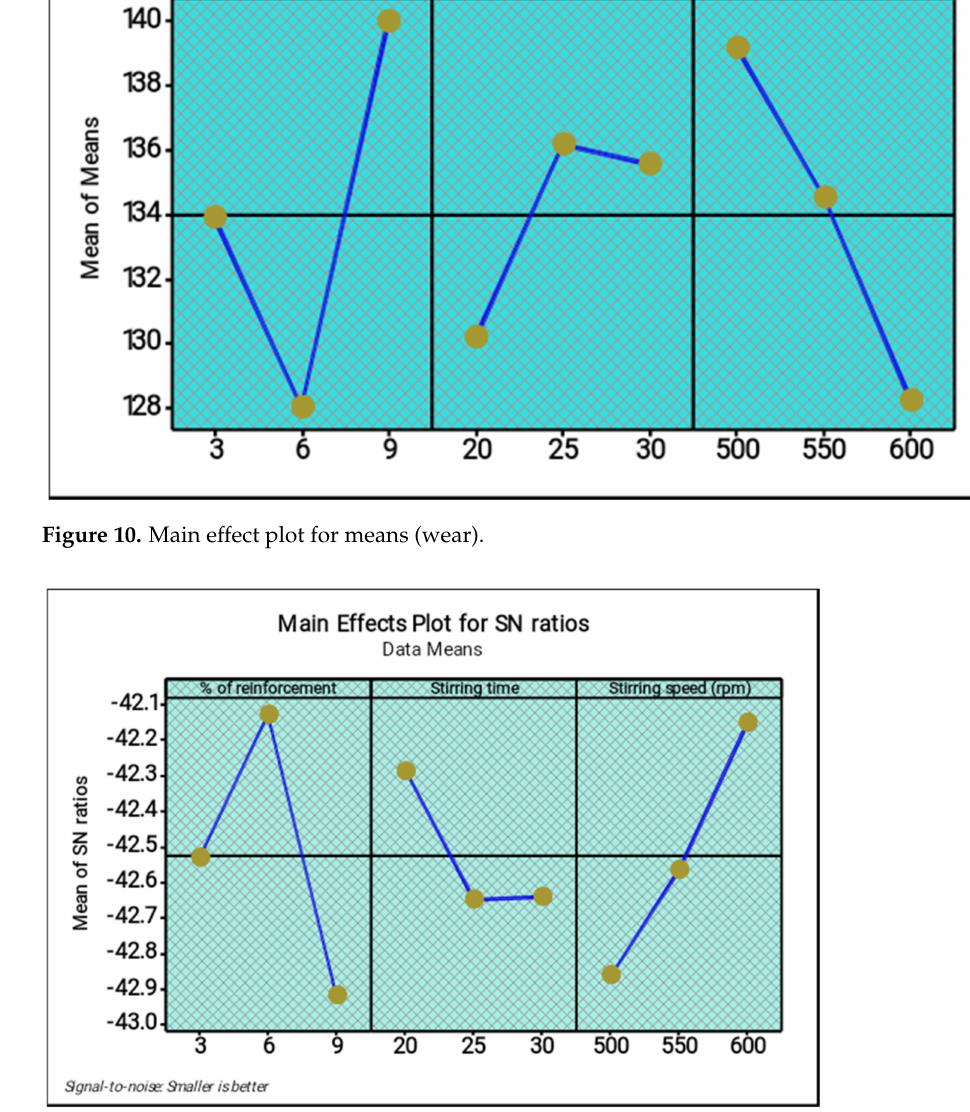
Figure 11. Main effect plot for S/N ratios